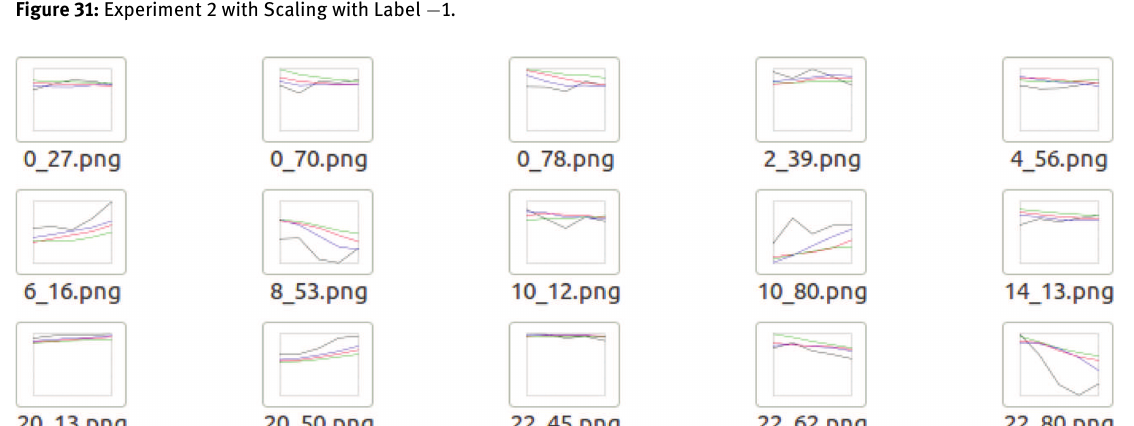
Figure 31: Experiment 2 with Scaling with Label − 1.